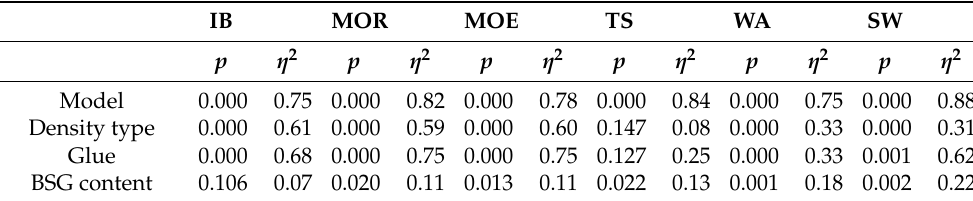
Table 2. Results of the ANOVA with p -values and 𝜂 (cid:2870) -values for the explanatory variables